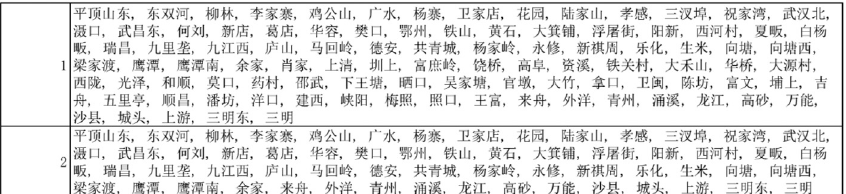
Figure 6. Stitching string of the actual wagon routing locus (From Pingdingshan East to